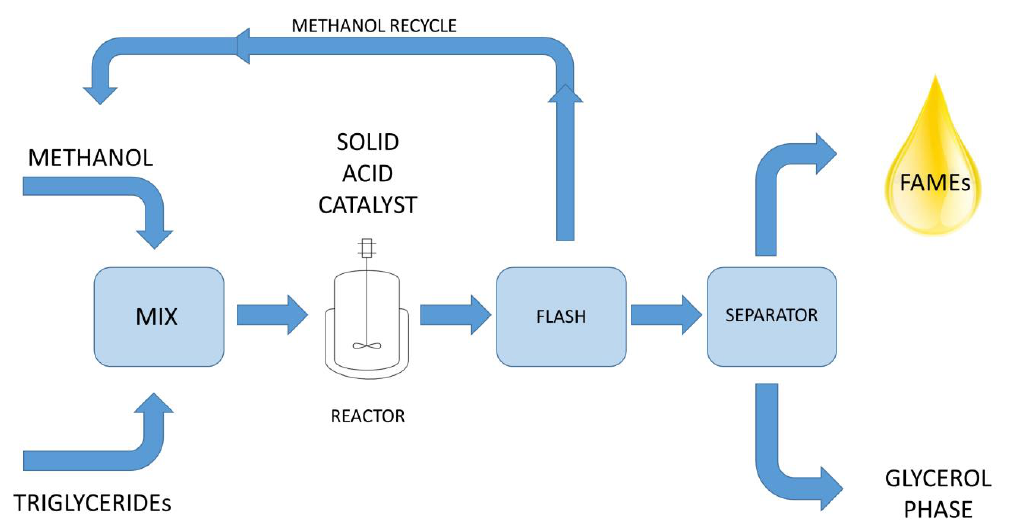
Figure 2. Simplified scheme of biodiesel production process.